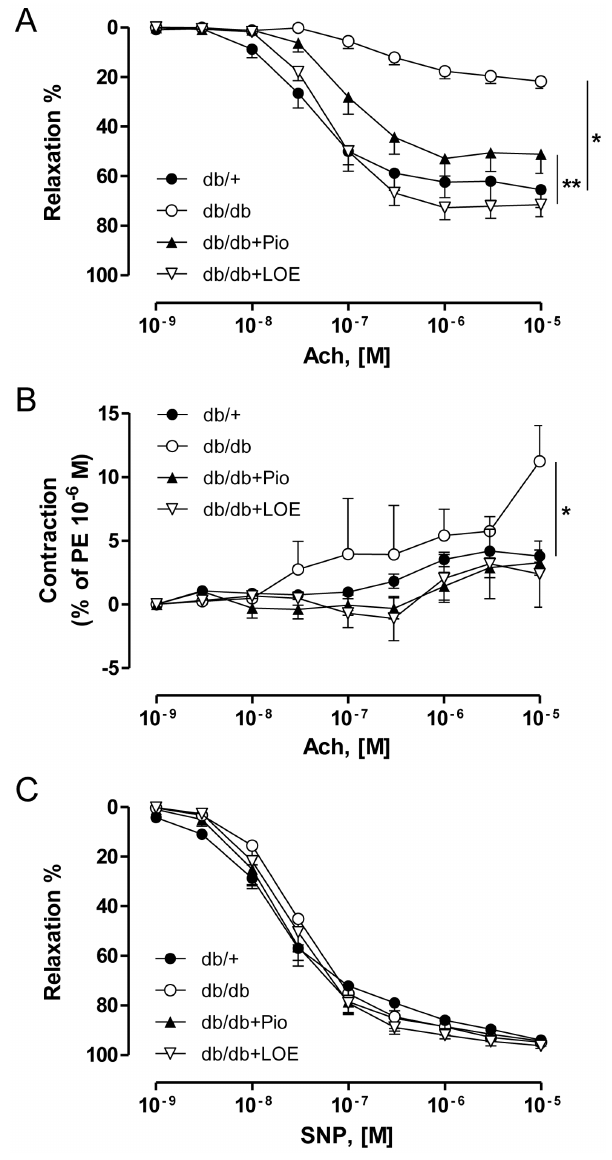
Figure 2. LOE and pioglitazone treatments improve endothe- lium-dependent relaxations and reduce endothelium-depen- dent contractile responses to acetylcholine in aortic rings of db/db mice. (A) Concentration-relaxation curves to Ach in aortic rings with endothelium, (B) concentration-contraction curves to Ach in the presence of N w -nitro L-arginine (an inhibitor of eNOS) in rings with endothelium, and (C) concentration-relaxation curves to sodium nitroprusside (a NO donor) in rings with endothelium in the presence of N w -nitro L-arginine and indomethacin to avoid the formation of endothelium-derived vasoactive NO and prostanoids, respectively. Values are shown as means 6 S.E.M. (n=5–6). * P , 0.05 indicates a significant difference between db/ + group versus db/db group, db/ db + Pio group or db/db + LOE group, and { db/db + Pio group versus db/ db + LOE group.pone.0065227.g003.tif